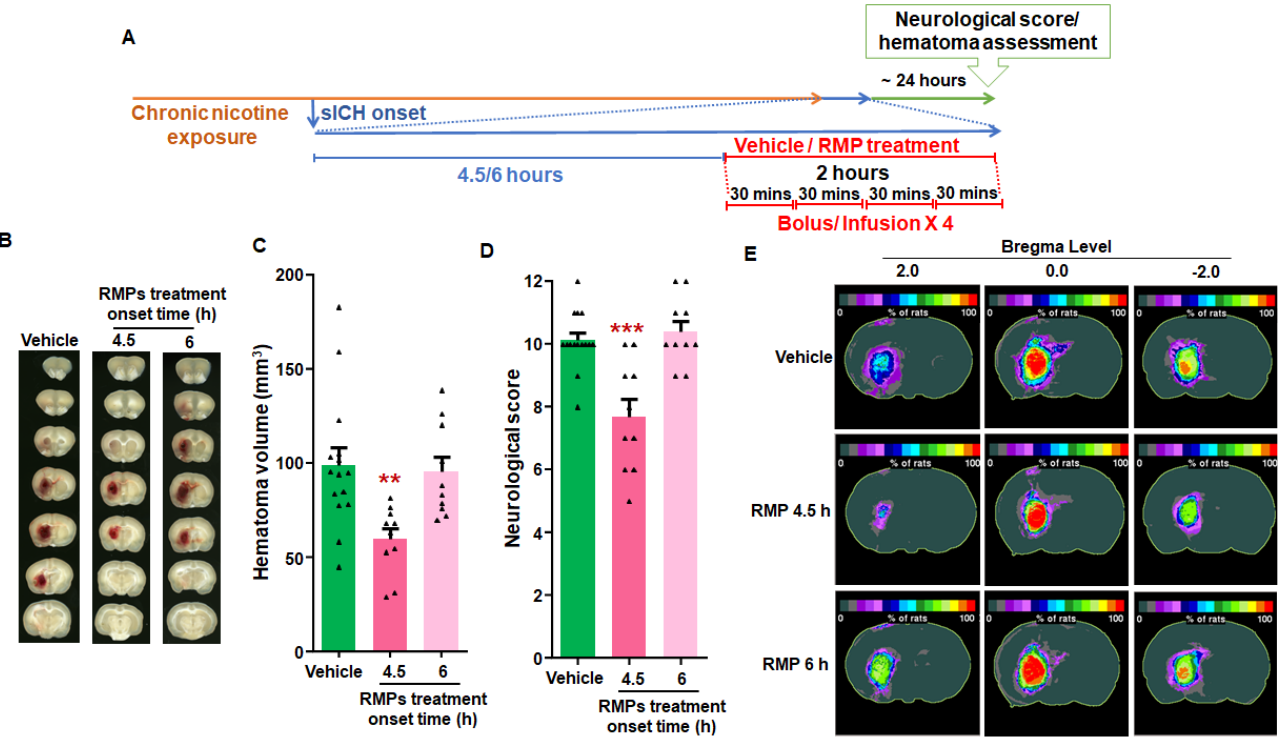
Figure 4. The effect of two different RMP treatment time points on hematoma expansion post-sICH in nicotine-exposed female rats: ( A ) representation of experimental design; ( B ) example images of brain scans showing mean hematoma volume; ( C ) mean hematoma volume data; ( D ) mean neurological score data; and ( E ) hematoma frequency maps at 3 coronal levels (bregma +2.0 mm, 0.0, to − 2.00 mm). The top row depicts the hematoma frequency maps of vehicle-treated rats, the middle row demonstrates hematoma frequency maps of 4.5 h post-sICH RMP-treated rats, and the bottom row shows the hematoma frequency maps of 6 h post-sICH RMP-treated rats. N = 15 for vehicle group, and n = 10 for RMP-treated groups. ** p < 0.01 and *** p < 0.005 vs. vehicle group.